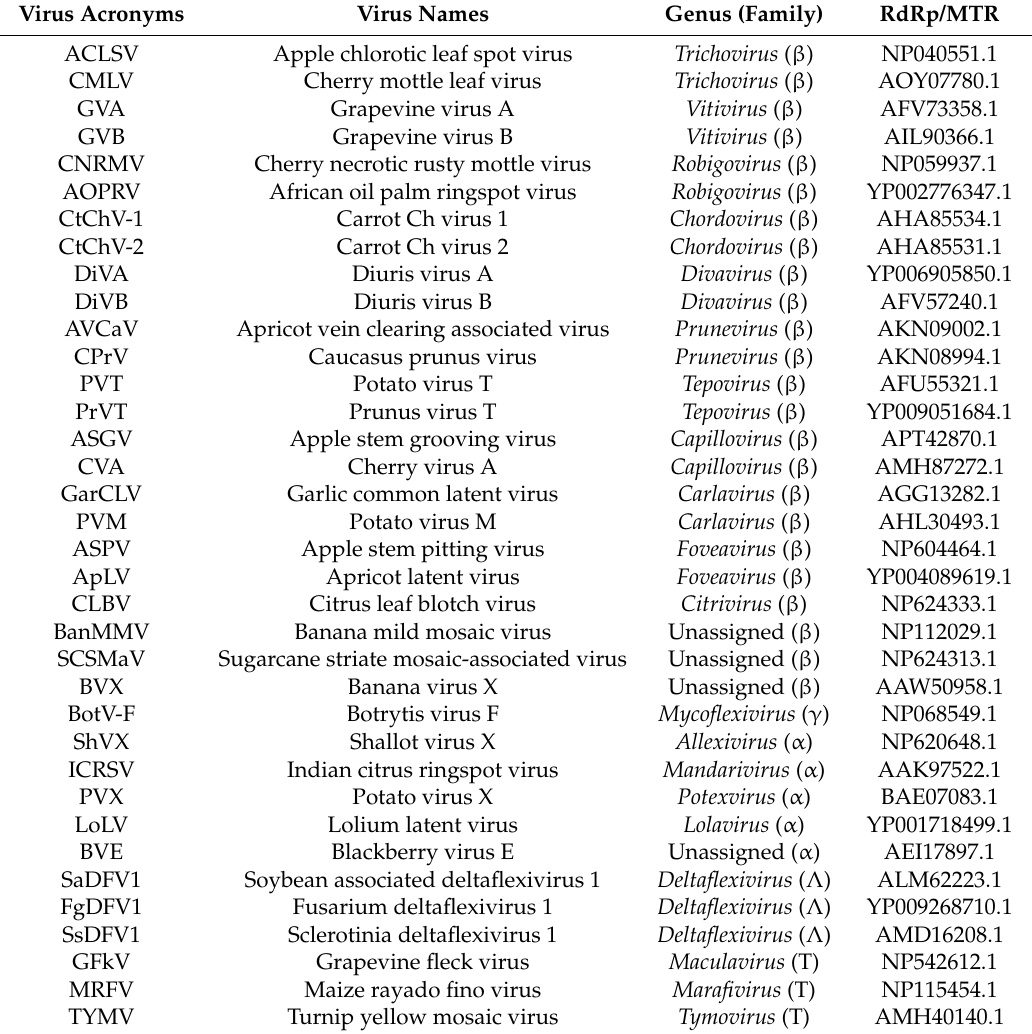
Table 1. Details of virus isolates used for the phylogenetic studies of Ribes americanum